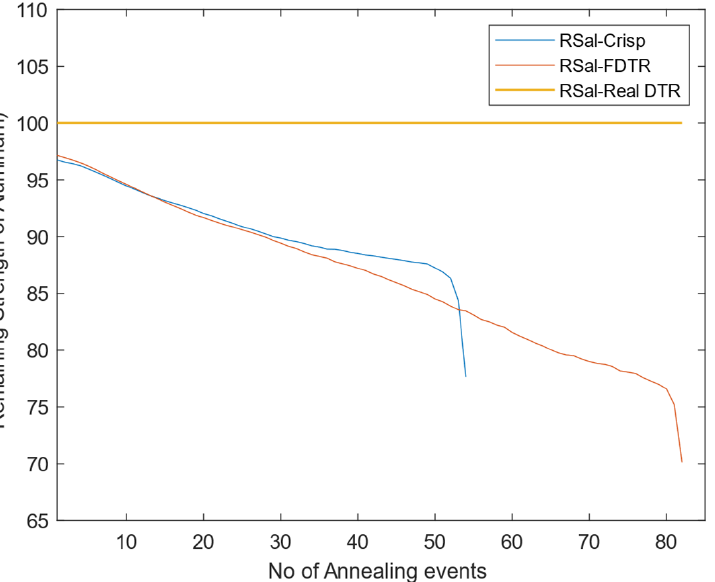
Figure 11. Remaining strength of aluminum (RSal) based on fuzzy, crisp, and real-time dynamic ratings over a twenty-year period.